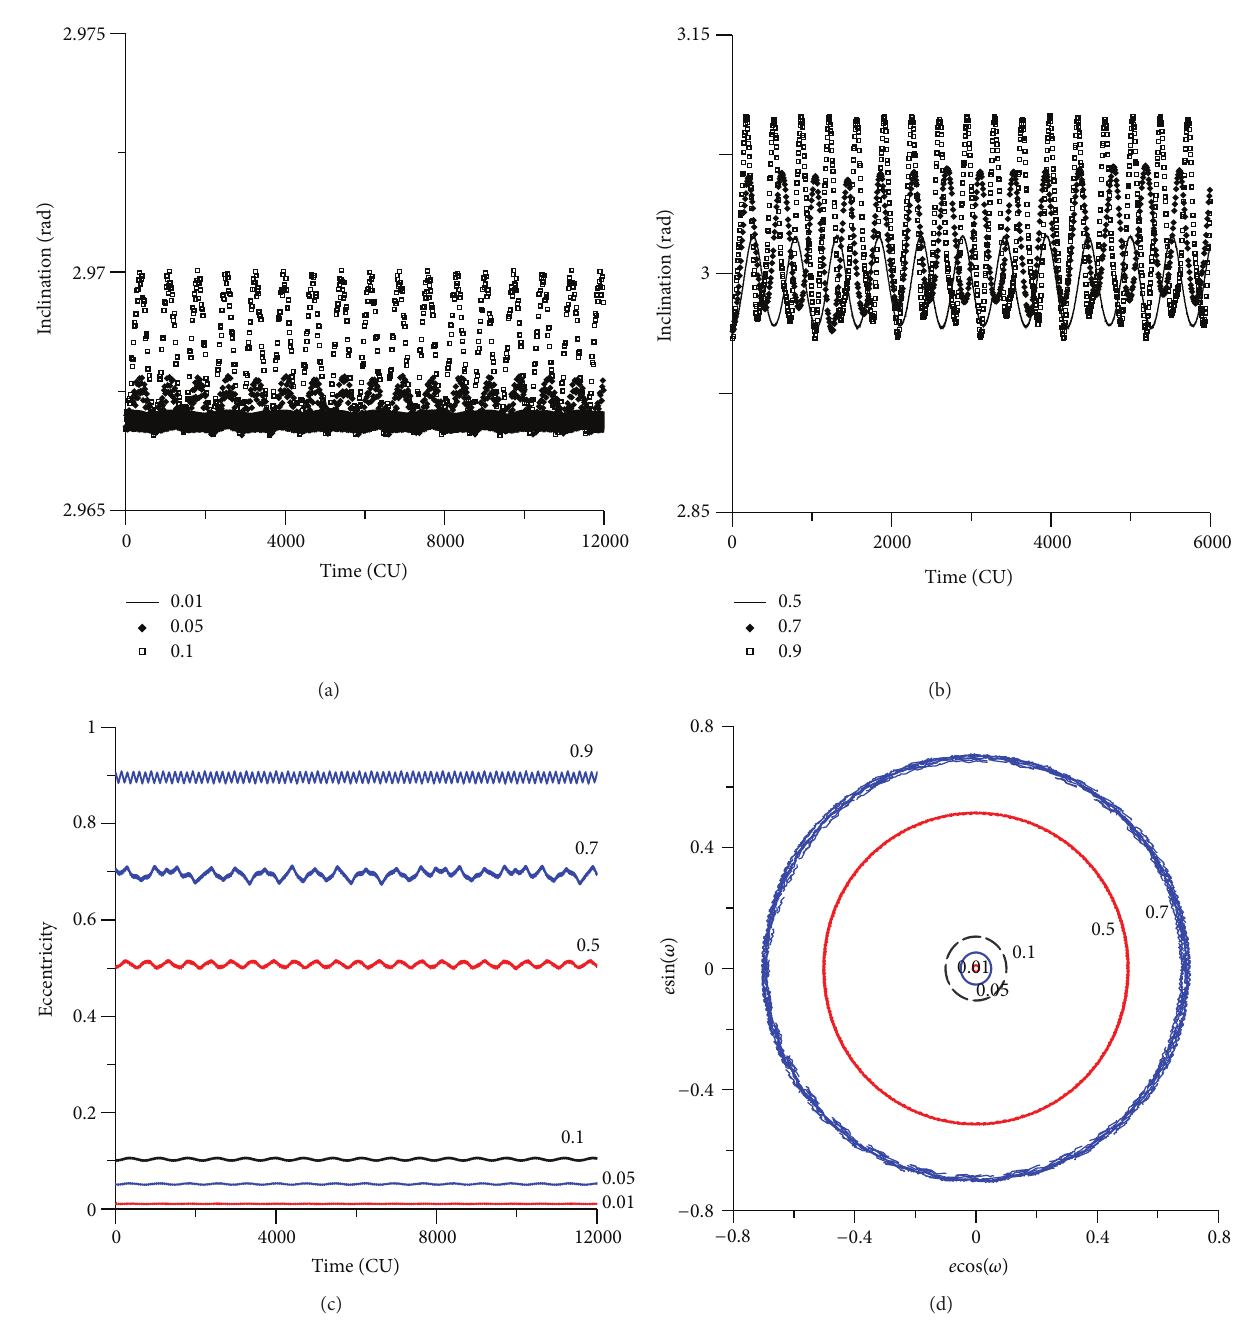
Figure 15: Behavior of the orbital elements for an initial inclination of 170 degrees. The values for the eccentricity are 0.01, 0.05, 0.1, 0.5, 0.7, and 0.9. The initial conditions are a = 0.341 canonical units, M 0 (0) = 0, 𝜔 (0) = 0, and Ω (0) =